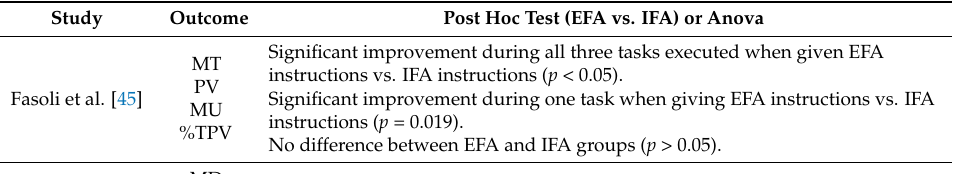
Table 2. Effects of attentional focus instructions on